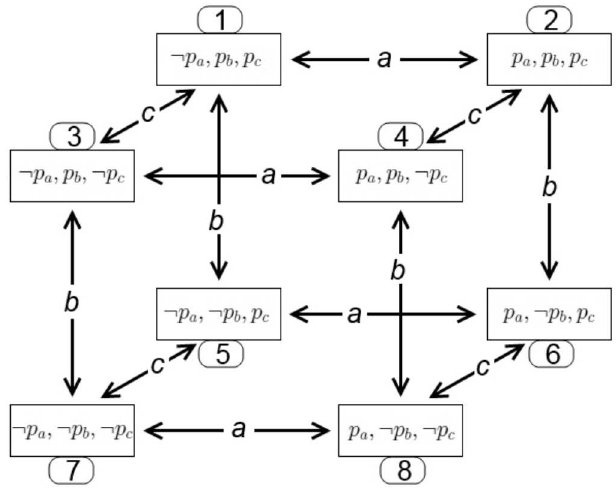
Figure 1. M (initial